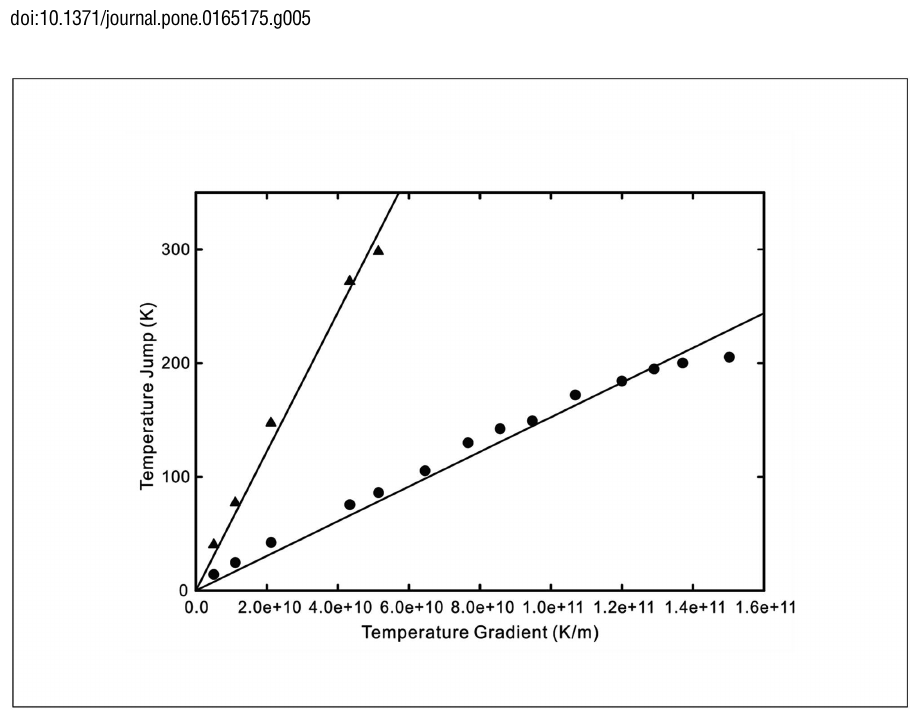
Fig 6. Temperature jump as a function of wall temperature gradient at a SAM-water interface. Symbols: MD simulation results for hydrophobic -CF 3 SAM (triangles) and hydrophilic-OH SAM (circles) [16]. Solid line: New temperature jump model from Eq 8 with C 1 = 6.121 × 10 − 9 for -CF 3 SAM at T w = 300 K , C 1 = 1.525 × 10 − 9 for -OH SAM at T w = 285 K .